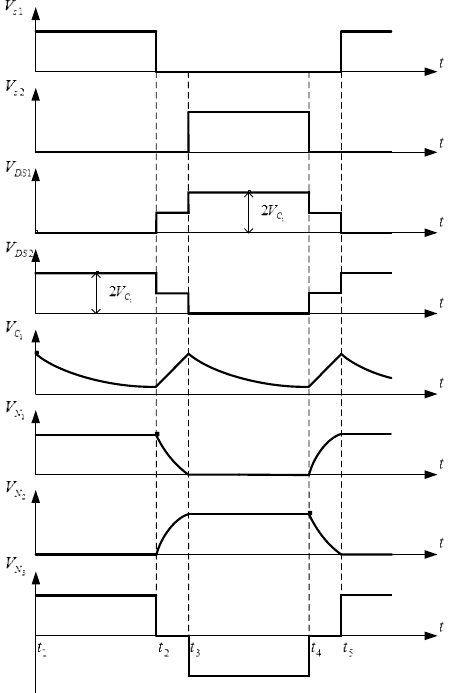
Figure 5. Principle waveforms of the voltages of the gate and between the source and the drain of power switch tubes S 1 and S 2 ; the primary and secondary ends of the transformer Tr and the capacitor C with respect to time variation in the constant-current isolation circuit.